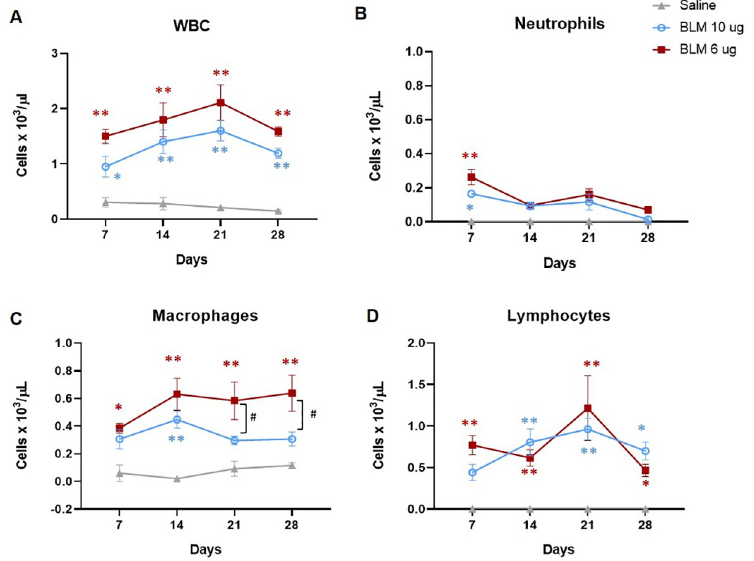
Fig 6. BAL cells count at different time-points. Levels of total white blood cells (A), neutrophils (B), macrophages (C) and lymphocytes (D) in BALF of animals receiving saline, the double dose of 10 μ g and the triple dose of 6 μ g at 7, 14, 21 and 28 days. Data are shown as mean ± SEM. The statistical differences were calculated by two-way ANOVA followed by Tukey’s test ( � p < 0.05; �� p < 0.01 vs. saline; # p < 0.05 BLM 6 μ g vs. BLM 10 μ g). N = 5 per group per time